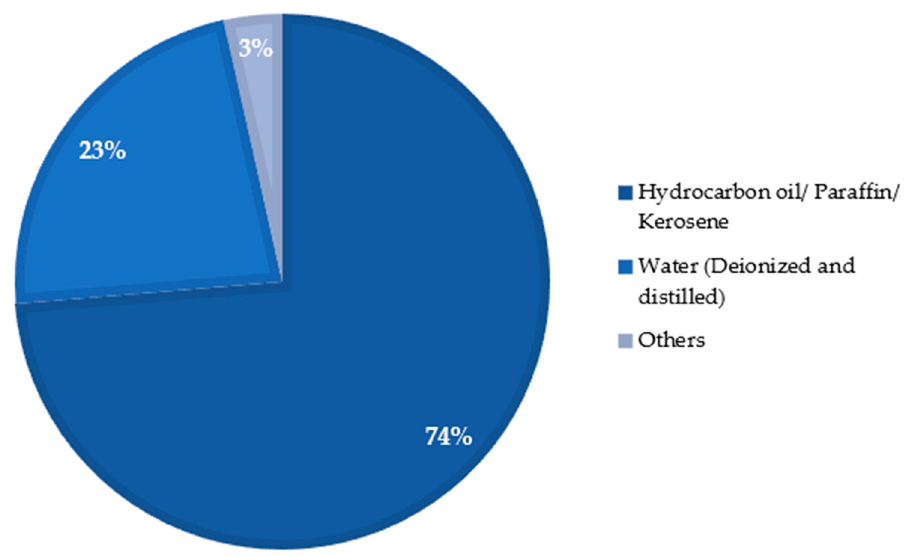
Figure 29. Types of dielectric fluids used in EDM processes (found in different publications reviewed in this study).